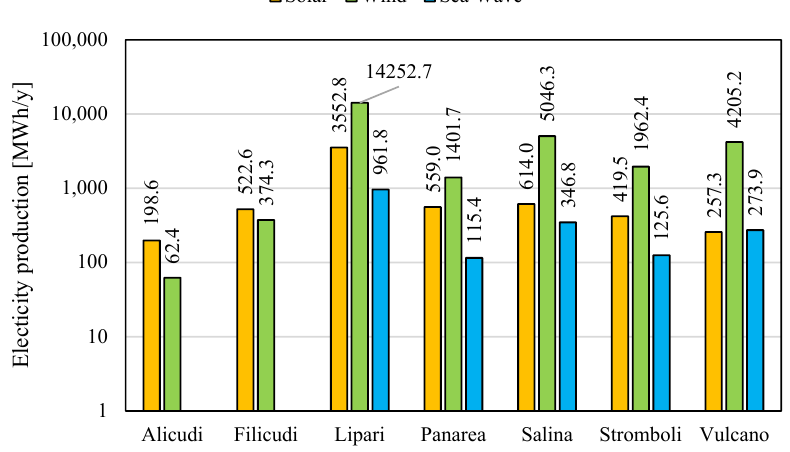
Figure 6. Total electrical production from RES in the Aeolian Islands.